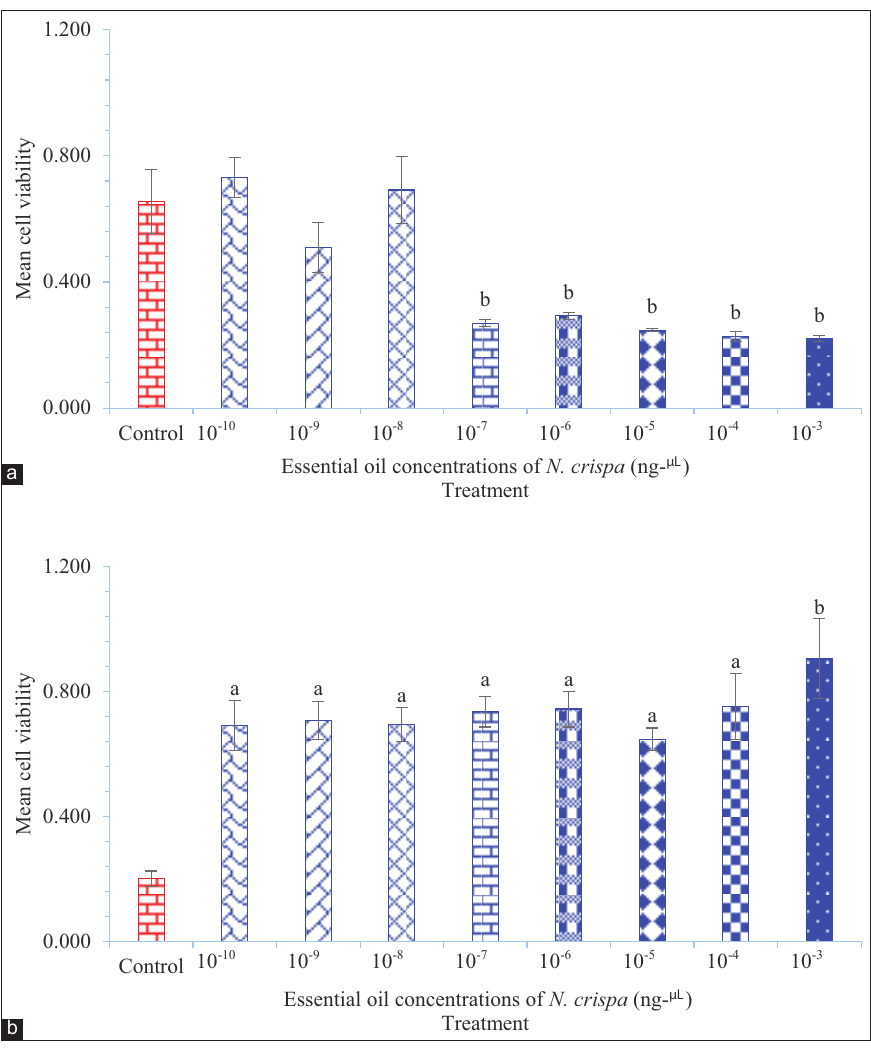
Figure-1: Cytotoxicity Nepeta crispa essential oil against invertebrate (Sf9) and vertebrate (L929) cell lines. (a) Essential oil of N. crispa plant against cell line of Sf9 and (b) essential oil of N. crispa plant against cell line of L929. Compared with control: (a) p<0.05 and (b) p<0.001. Cell line of Sf9 derived from the ovary gland of the fall armyworm, Spodoptera frugiperda (Smith) (Lepidoptera: Noctuidae). Cell line of L929 derived from mouse fibroblast